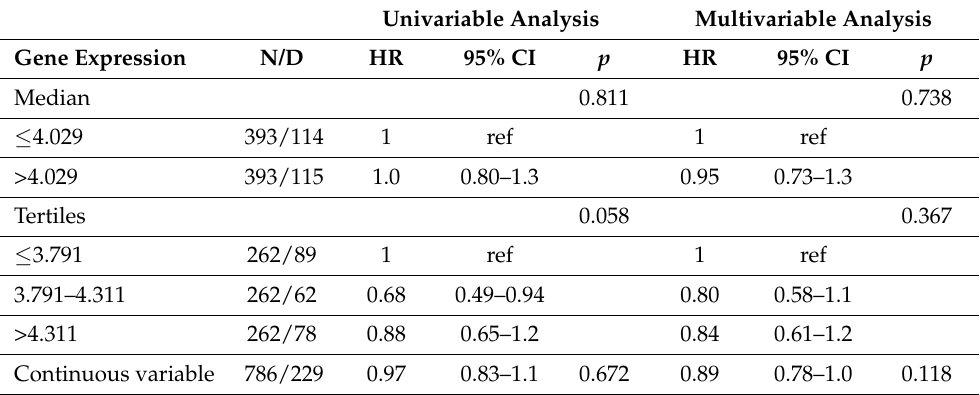
Table 17. Overall Survival of 786 NB patients in relation to GREB1 expression levels evaluated by the Cox model.